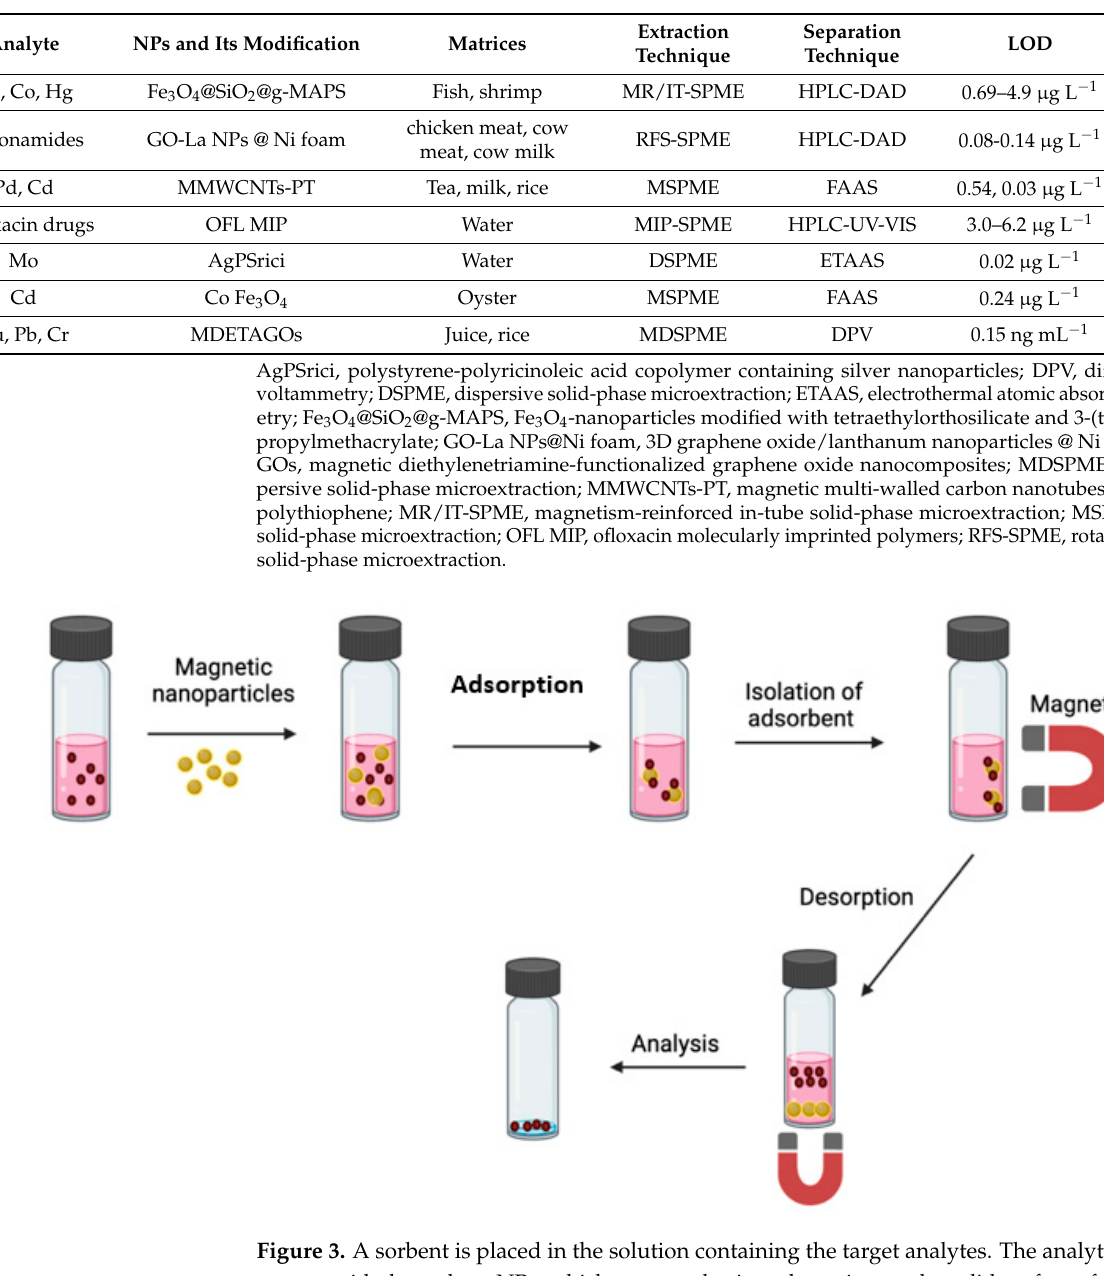
organic compounds such as MIPs, surfactants, and divinylbenzene. Table 5 shows the main applications for